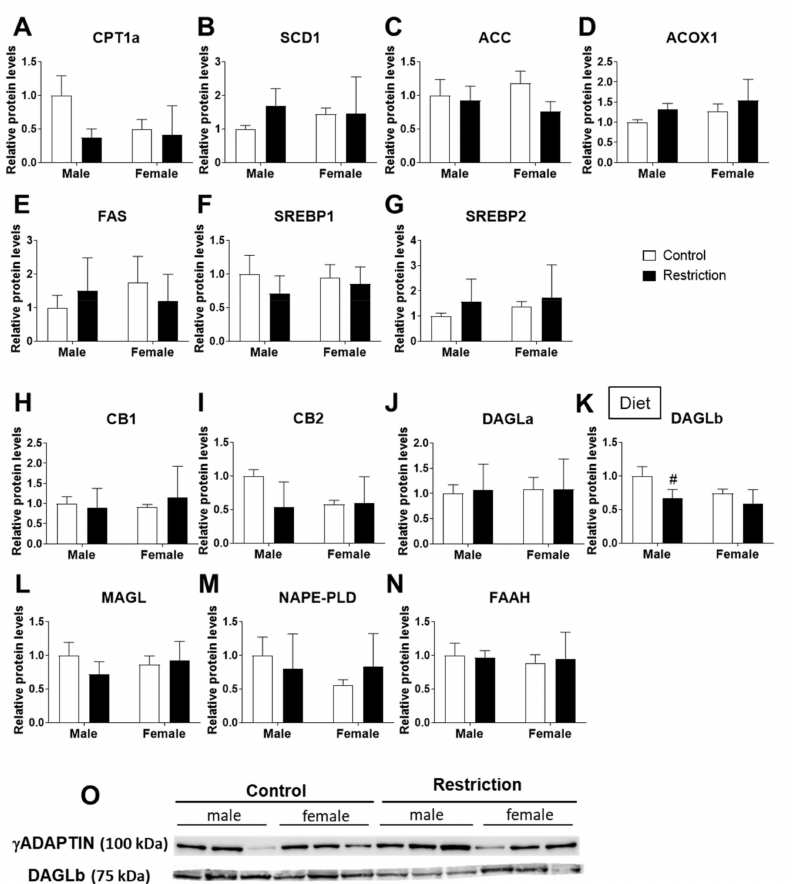
Figure 4. Effect of maternal caloric restriction on protein levels of principal factors of lipid metabolism: Cpt1a ( A ), Scd1 ( B ), Acc ( C ), Acox1 ( D ), Fasn ( E ), Srebf1 ( F ) and Srebf2 ( G ); and the endocannabinoid system: Cnr1 ( H ), Cnr2 ( I ), Dagla ( J ), Daglb ( K ), Magl ( L ), Nape-pld ( M ) and Faah ( N ) in the hypothalami of male and female offspring at postnatal day 2. Representative membranes of the main changes ( O ). Data are expressed as the mean ± S.E.M. (control male: n = 11; restriction male: n = 9; control female: n = 10; restriction female: n = 6. Tukey or single-effect analysis: # p < 0.05/0.01/0.001 vs. same-sex control group. The main results of the two-way ANOVA (effect of sex, diet and/or sex × diet interaction) are indicated above the